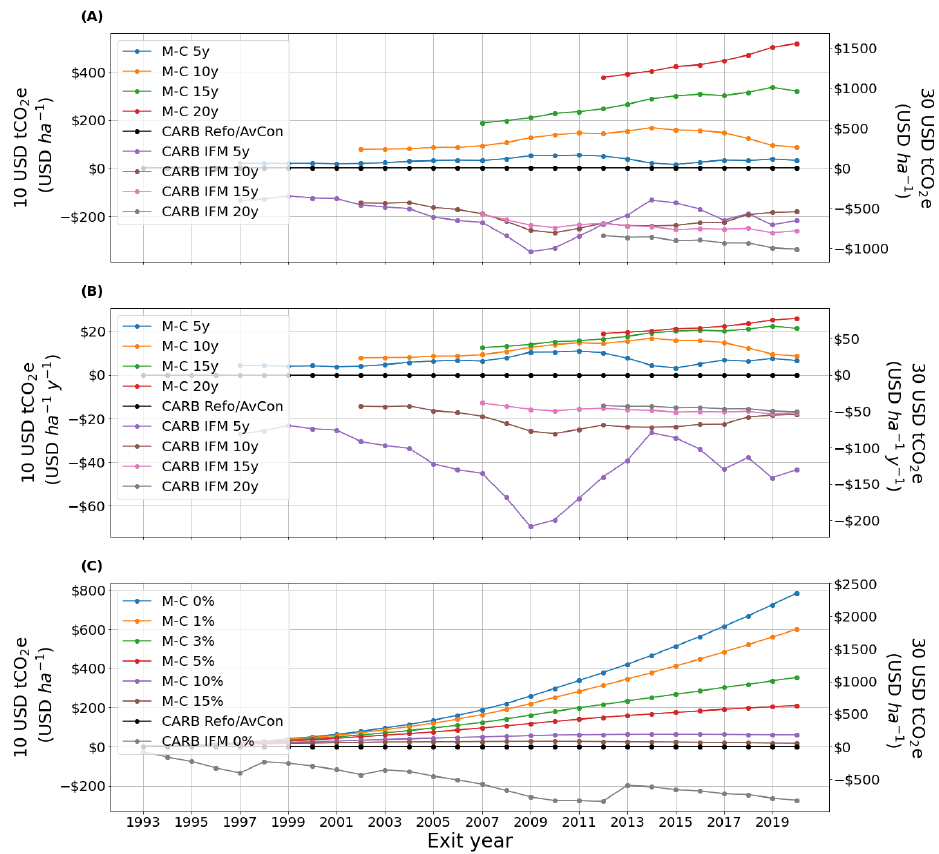
Figure 3. ( A ) Ton-year accounting return per ha for projects that stored carbon for 5 (blue), 10 (orange), 15 (green), and 20 (red) years, using the Moura-Costa approach, and CARB protocol returns for reforestation and avoided conversion projects (Refo/AvCon; black), for improved forests management (IFM) in 5 (purple), 10 (brown), 15 (pink), and 20 (grey) years. ( B ) Same as ( A ) but showing yearly mean returns. ( C ) Returns per ha using the same carbon pricing scenarios as ( A ) for projects that started in 1992 and finished in one exit year, discounted at 0% (blue), 1% (orange), 3% (green), 5% (red), 10% (purple), and 15% (brown) calculated with the Moura-Costa approach and with both CARB protocols without discounting (black and grey). In this case, there are 28 projects for each discount rate with different lengths.